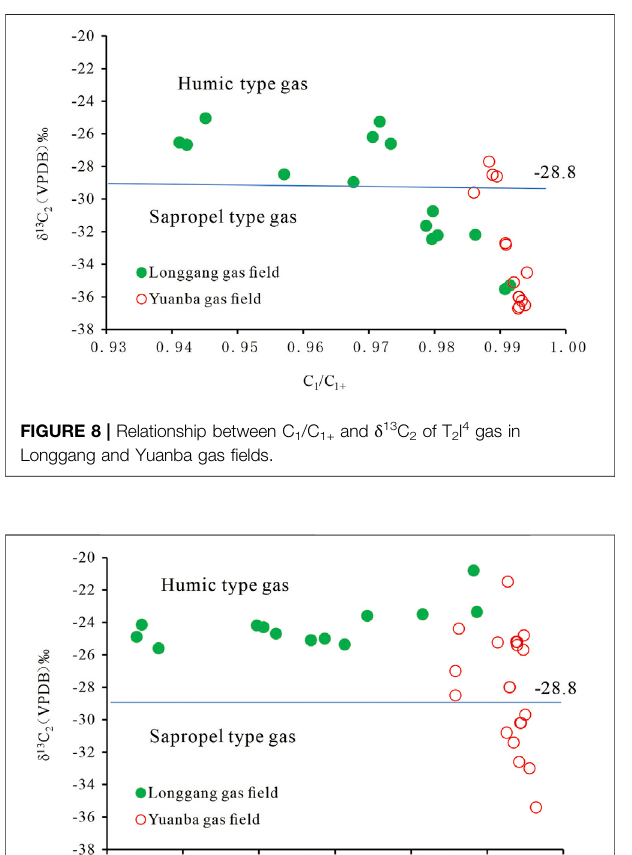
Frontiers in Earth Science |